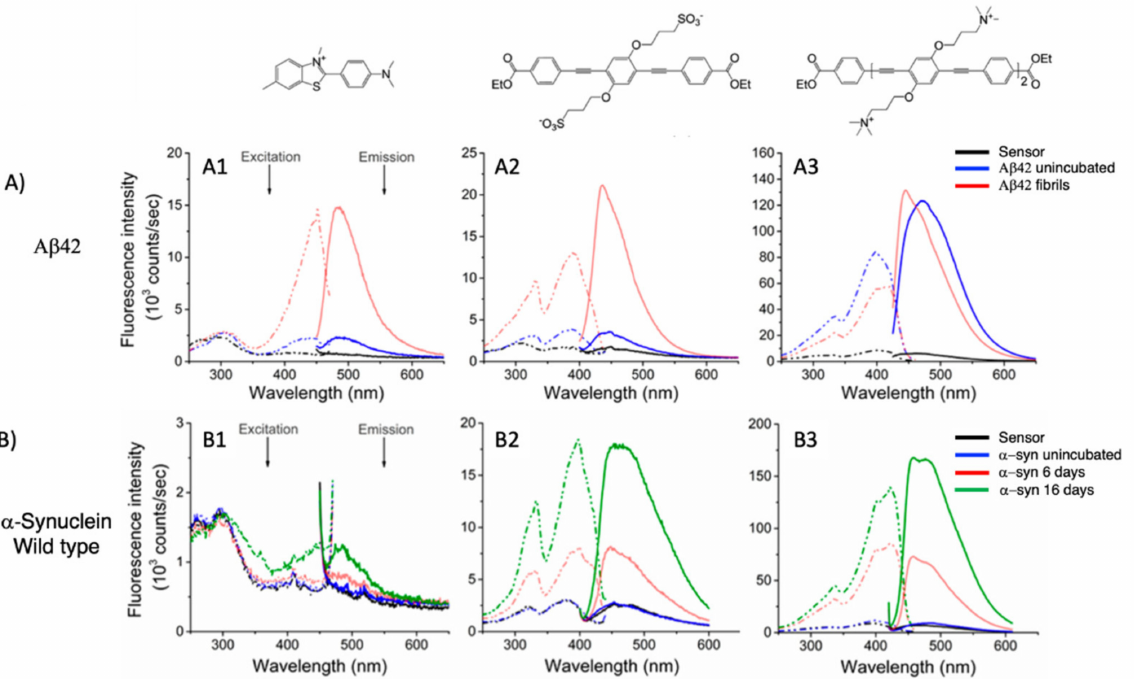
Figure 6. ( A ) Excitation (dashed line) and emission spectra (solid line) of ThT (A1), 19c (A2), and 18e (A3) in the presence of A β 42 (up) alone (black line), in the presence of A β 42 unincubated (blue line), and in the presence of A β 42 fibrils (red line). ( B ) Excitation (dashed line) and emission spectra (solid line) of ThT (B1), 19c (B2), and 18e (B3) in presence of α -synuclein wild type (bottom) alone (black line), in presence of α -synuclein unincubated (blue line), and in presence of α -synuclein after 6 days of incubation (red line) and after 16 days (green line). Adapted with permission from [40]. Copyright 2019 American Chemical